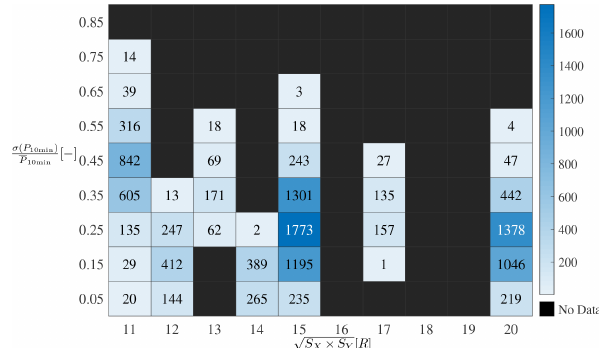
Figure 12. Heatmap showing number of 10min realizations for dif- ferent bins of relative spacing and standard deviation of power pro- duction based on a total of 12016 realizations. Values on axes show center